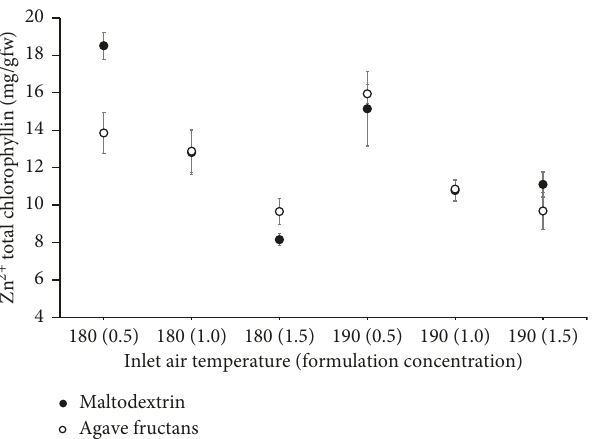
Figure 1: Content of Zn 2+ chlorophyllin derivatives in powders for which two types of carrier agents (MD and agave FOS) were used.